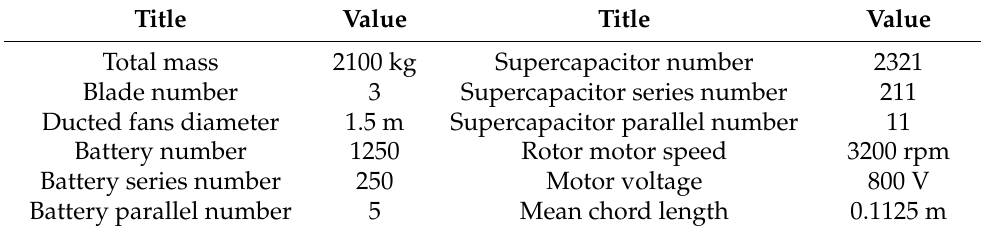
Table 4. Optimization results of sizing